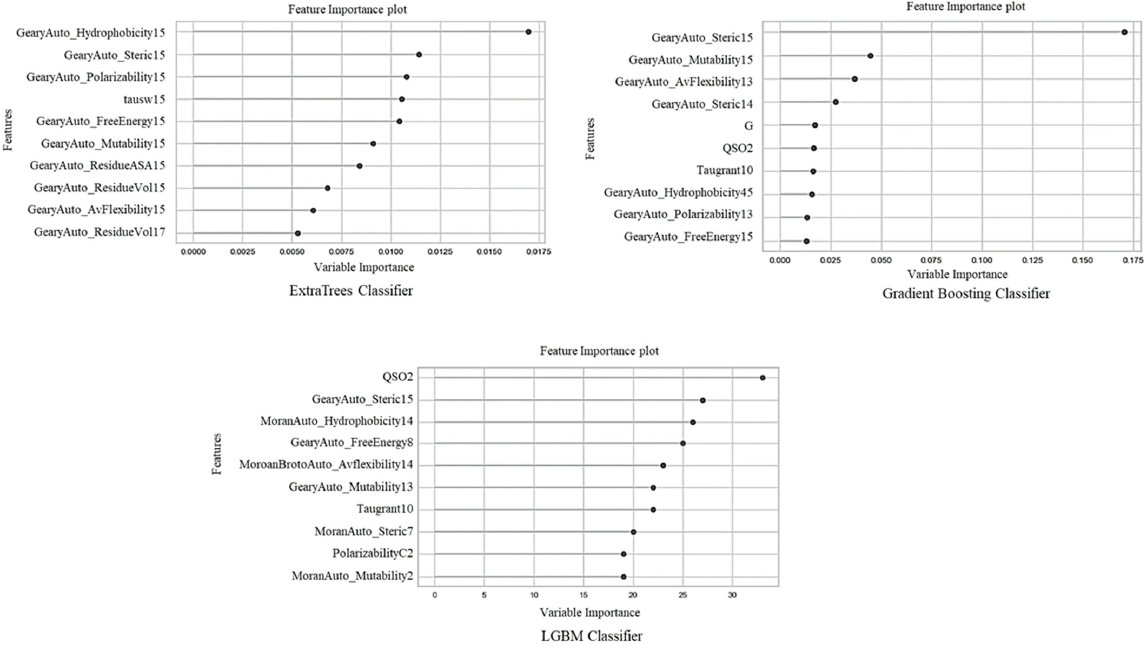
Figure 5. A plot of the top 10 important features for the IL-10 training datasets.